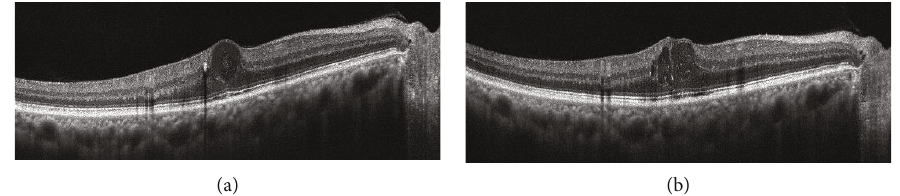
Figure 3: A 74-year-old male had an UACR of 0.029. (a) At baseline, there was cystic edema involving fovea in the right eye. (b) At month 12, the cystic edema still persisted after 8 ranibizumab injections were